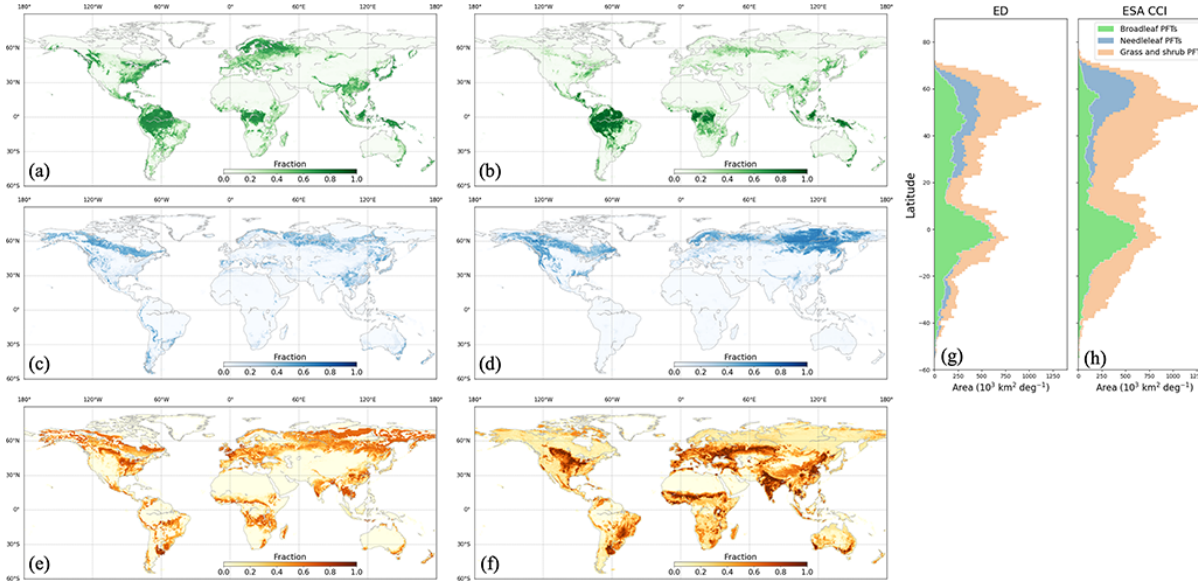
Figure 3. Spatial distribution of broadleaf PFTs, needleleaf PFTs, and grass and shrub PFTs in 2015 from ED (a, c, e) , and from ESA CCI (b, d, f) . The corresponding latitudinal total areas are compared in (g) and (h)